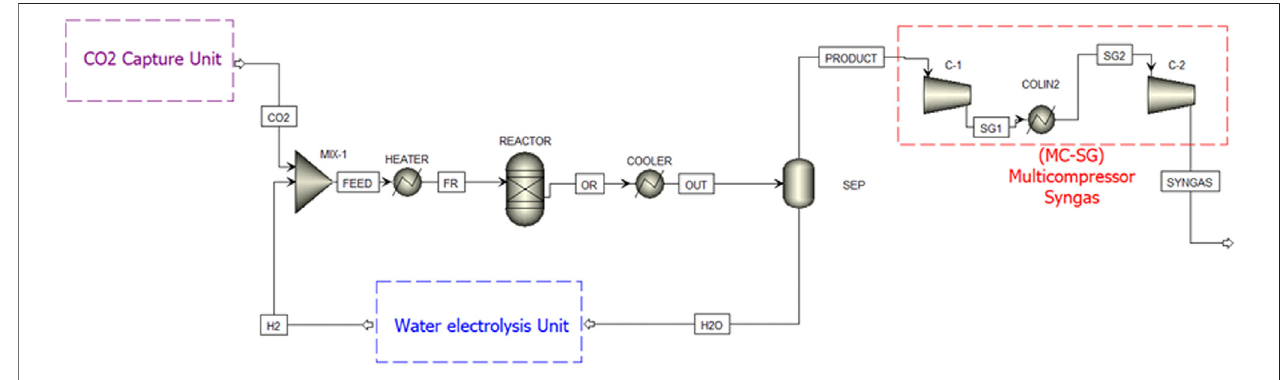
FIGURE 1 | Flowsheet of the thermodynamic simulation in Aspen Plus ® including compression units (MC-SG), split block (SEP) and heat exchange systems.